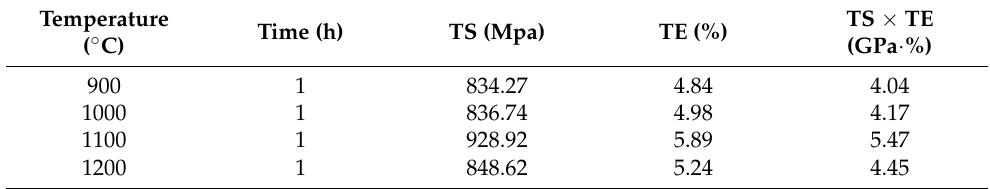
Table 2. Mechanical properties of the experimental steel after solution treatment at different temperatures.